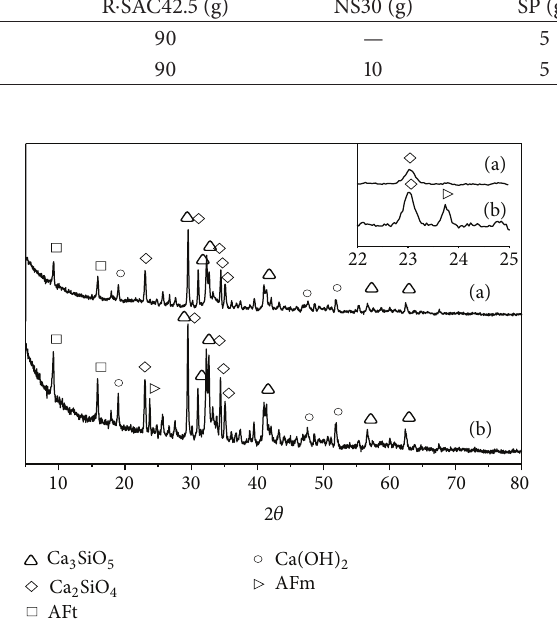
Figure 11: XRD of cement paste (a) without NS and (b) with NS30/4.0 at 1 day.